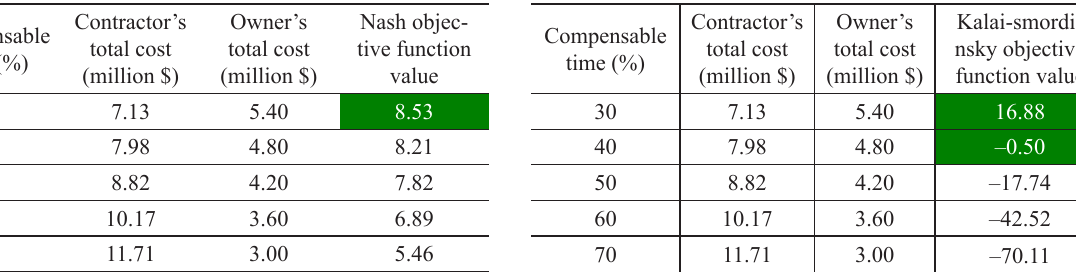
Table 4. Kalai–Smorodinsky objective function value against the compensable time